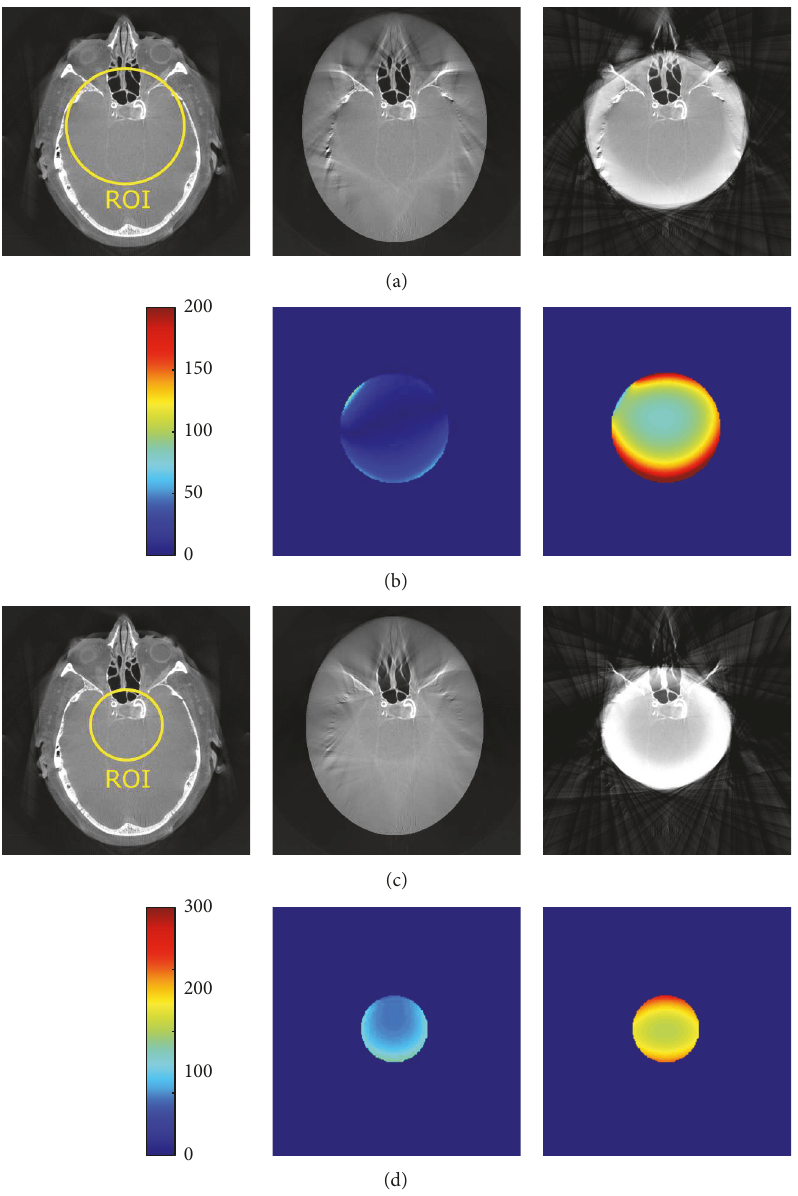
Figure 6: Reconstruction results of the reprojected clinical dataset 1 with both medium truncation (a) and severe truncation (c). (b) and (d) show the corresponding difference images with respect to the reference (only computed in the ROI region). From left to right: reference from nontruncated data, proposed correction method, and water cylinder extrapolation (cf. Berger et al. [8]). The grayscale window: 𝐶 = 0 HU, 𝑊 = 2000